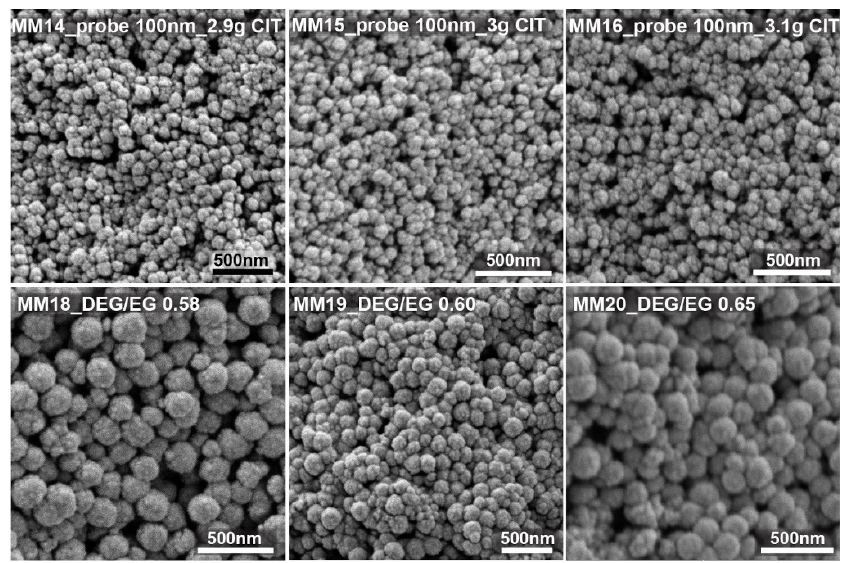
Figure 4. The top three SEM images show nanocrystal clusters prepared by varying the citrate amount between 2.9 and 3.1 g, with a constant DEG/EG ratio equal to 1. The bottom three images show SEM images of nanocrystal clusters obtained from different DEG/EG ratios but a constant citrate amount of 3 g.